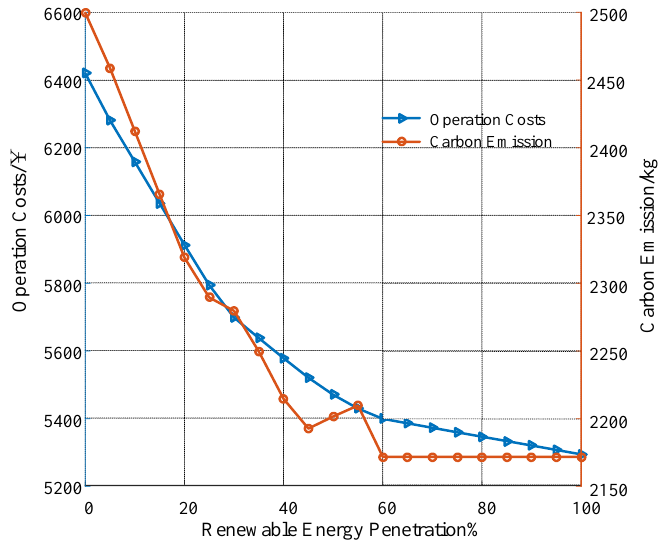
Figure 12. Influence of renewable energy penetration on PIES operation.